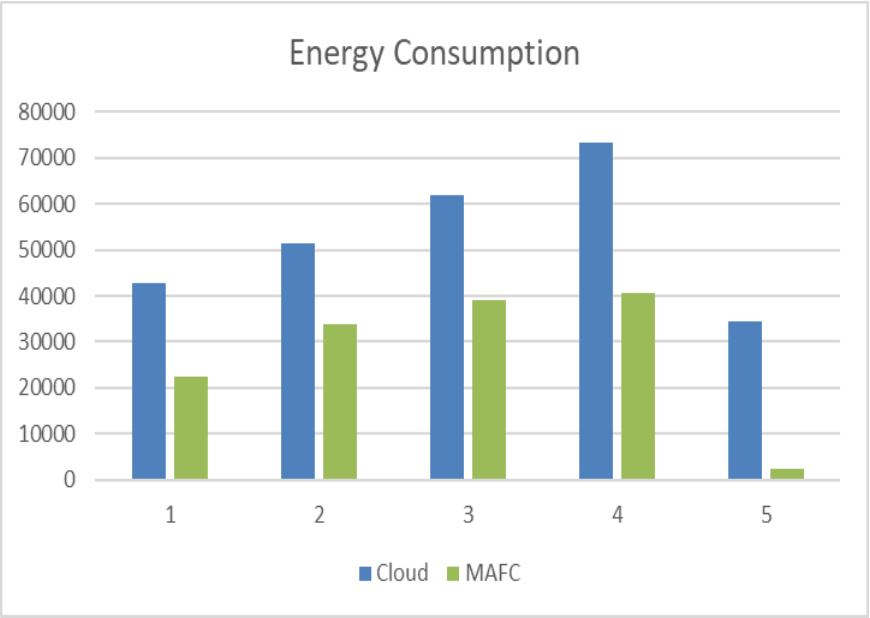
Figure 10. Energy consumption of MAFC and Cloud datacenters .